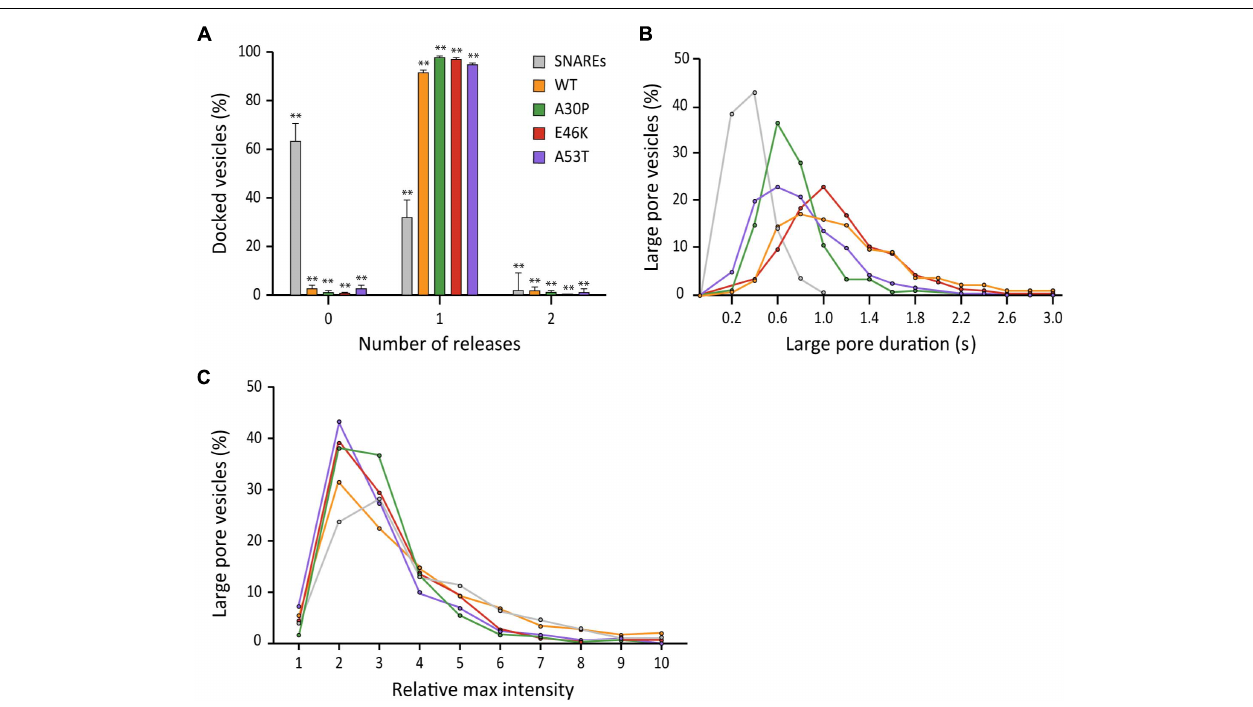
FIGURE 7 | Familial mutations A30P and A53T of α S moderately reduce the duration of the large fusion pore. (A) Distribution of docked vesicles vs. number of large pore fusion events. In total for α S A30P, 288 large pore fusion events were detected from 290 total events from 4 independent measurements. For α S E46K, 326 large pore fusion events were detected from 331 total events from 5 independent measurements. For α S A53T, 322 large pore fusion events were detected from 337 total events from 7 independent measurements. Error bars represent standard deviations from means. The data are shown as means ± SD. ∗∗ p < 0.01 by Student’s t -test; n = 3 independent experiments. (B) Distribution of the duration of the large fusion pore. (C) Distribution of relative maximum intensities of large pore fusion